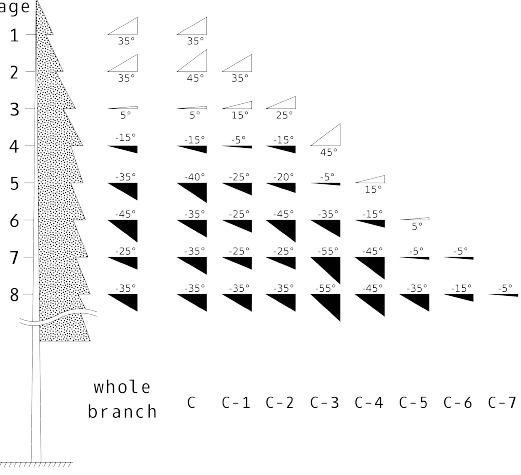
Figure 2. Average angular distribution of spruce shoots according to their ages (c—current shoots, c-7 are 8-year-old shoots) and vertical position as measured by Barták [54] for 35-year-old Norway spruce trees at Bílý Kˇriž